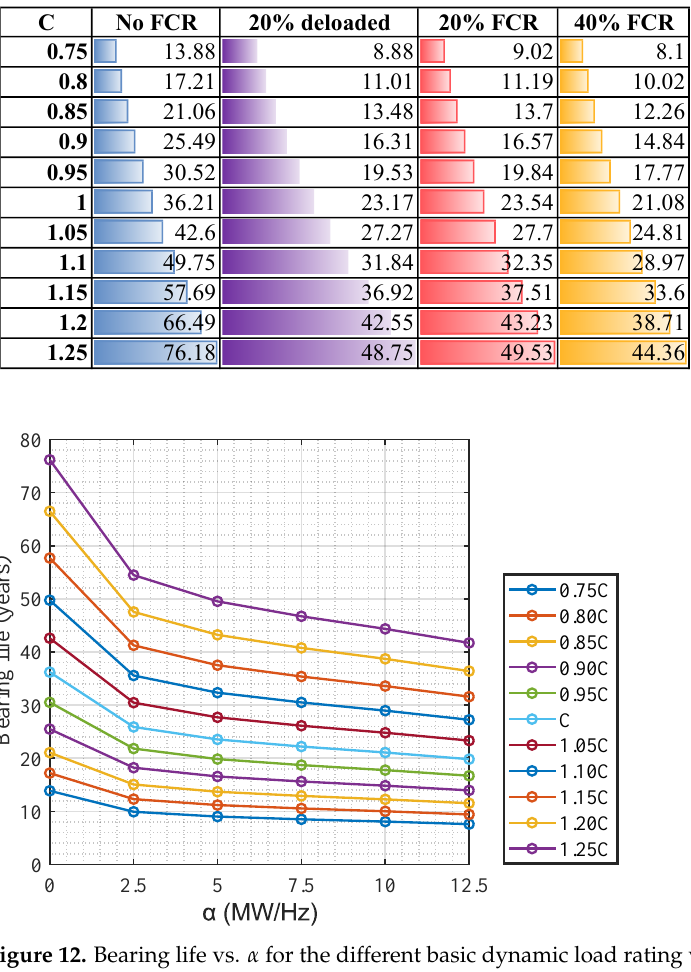
Table 3. Bearing life, in years.